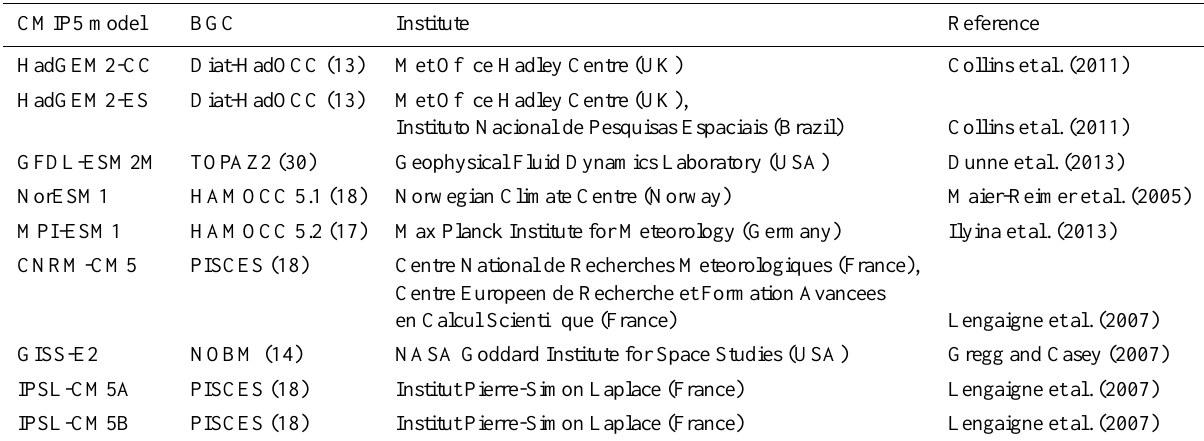
Table 9. CMIP5 models used for intercomparison with M EDUSA -2.0. Each entry lists the component biogeochemical submodel, the number of state variables (in brackets) and the host institution for each